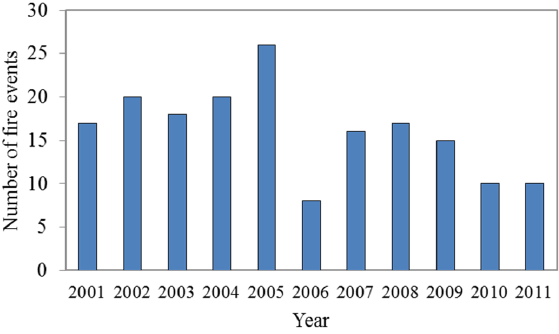
Figure 7. Number of fire events in every year from 2001 to 2011 at the WIMO1 site.